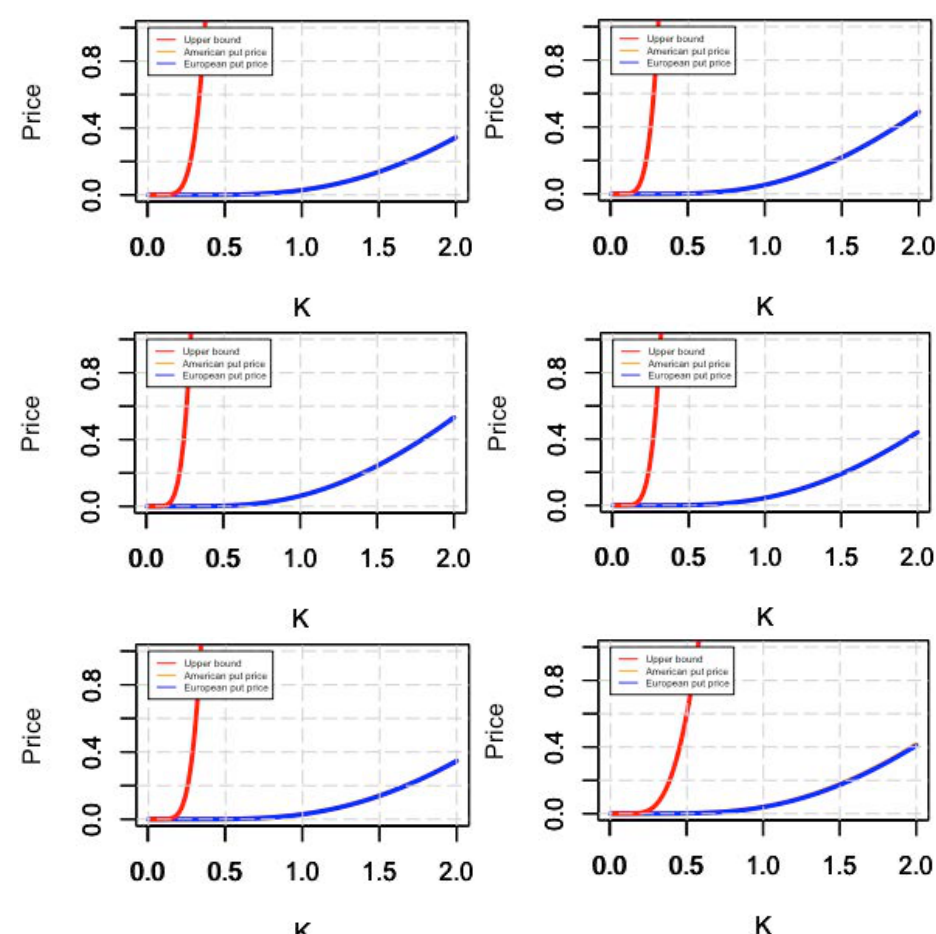
Figure 5. Put option prices written on FNMA during COVID-19. The figure shows the price of American options (yellow lines), European options (blue lines), and bounds for optima exercise of American options (red lines). January, February, March, April, May and June